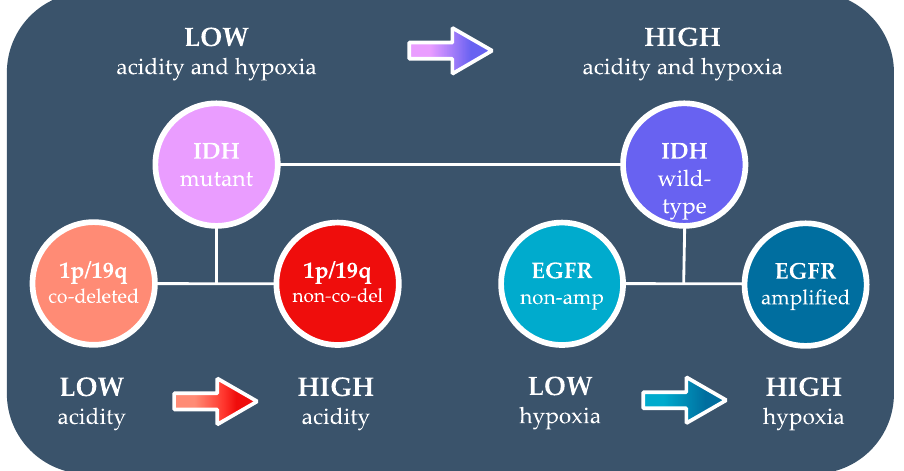
Figure 9. Summary of hypothesized tumor microenvironment differences in glioma genotypes